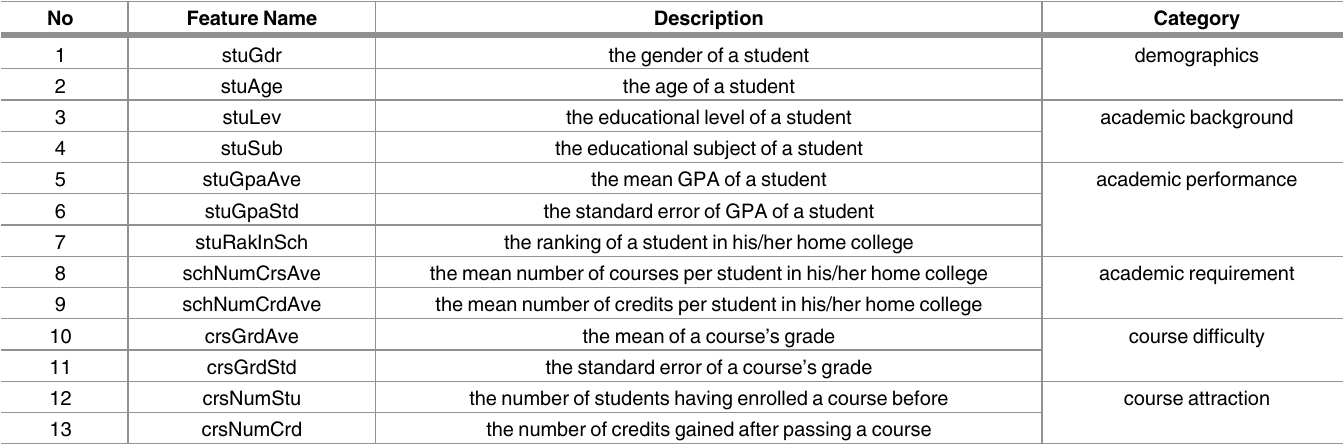
Table 1. Definitions of the logs-based